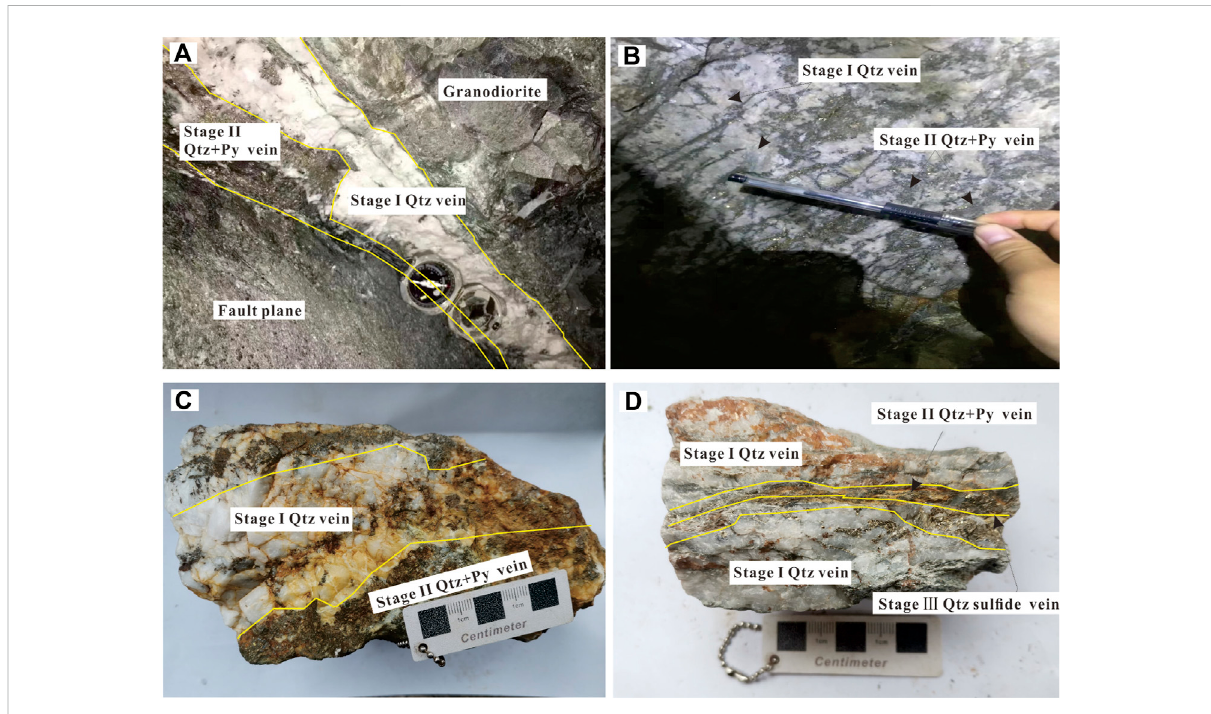
FIGURE 3 Photographs of various mineral assemblages and mineralization stages in the Houge ’ zhuang gold